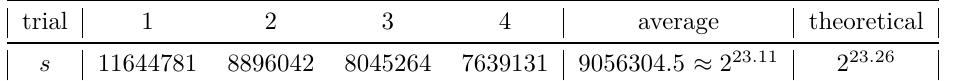
Table 4: Experimental result for the attack on the longevity of Yoroi